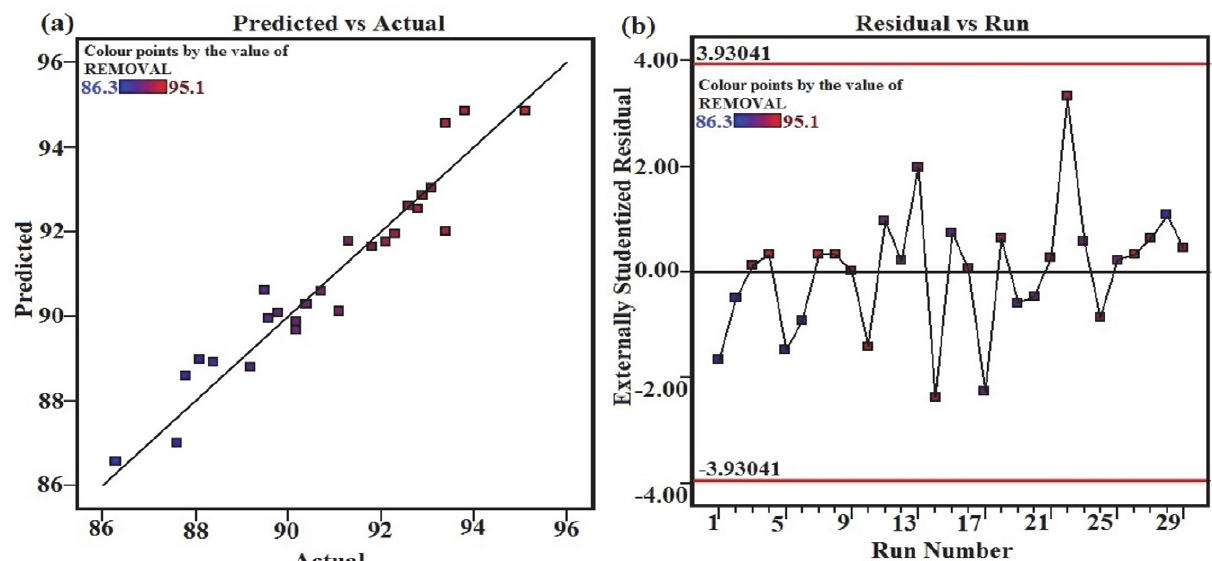
Fig. 2. RSM model graphs of a) Predicted vs Actual values b) Studentized residuals vs experimental run number on optimized parameters of As(V)